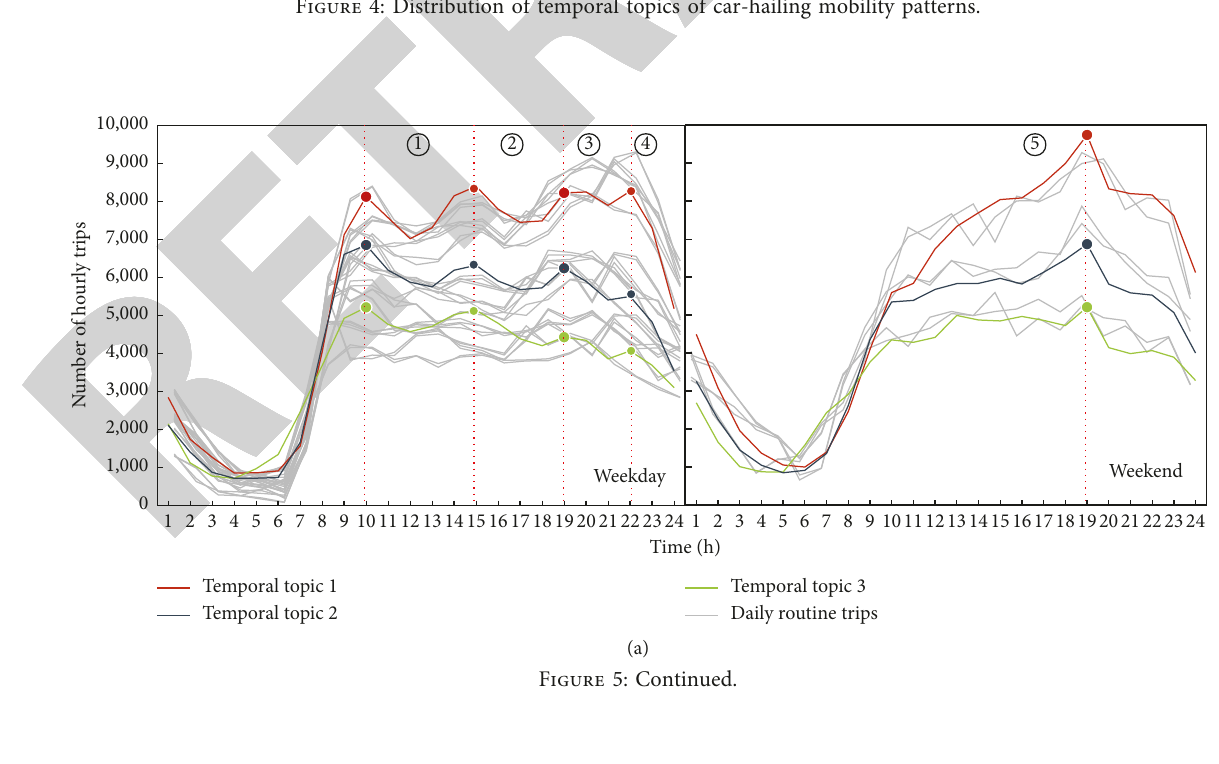
Figure 4: Distribution of temporal topics of car-hailing mobility patterns.